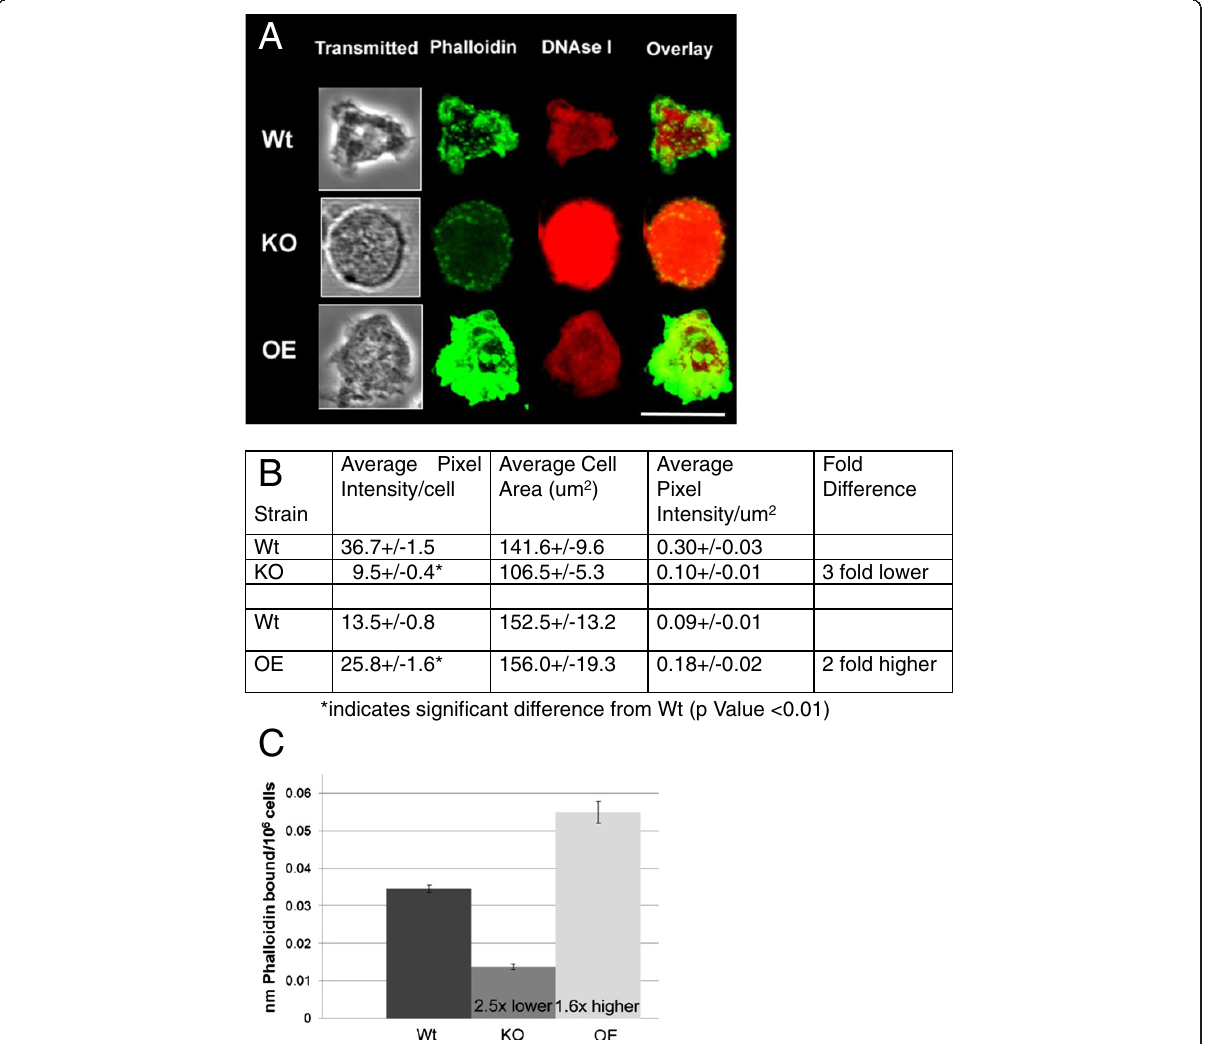
Figure 2 AmpA influences the level of polymerized F actin. A ) Wild type, amp A knockout (KO) and overexpresser (OE) cells were stained with Alexa 488-phalloidin to detect F-actin (green) and TRITC labeled DNAse I to detect G-actin (red). Imaging conditions were optimized for levels of phalloidin staining (see Methods). The fields of cells from which the representative individual cells were excised are in Additional file 5. The images are 3D reconstructions from a confocal z series. Scale bar is 20 um. The fluorescent F-actin images were all equally enhanced to more clearly see the F-actin in the ampA knockout. B ) Fields of Wt, KO and OE cells stained with Alexa 488 phalloidin shown in Additional file 5 were quantified (see Methods). The average pixel intensity per cell, cell surface area and pixel intensity/um 2 are shown. Significance was determined by a two-tailed paired Student ’ s t-test with a p value < 0.05 indicated as significantly different from Wild type. 15 to 20 cells per strain were quantified per experiment. The staining experiment was repeated 6 different times with cells grown on different days. C ) The amount of Alexa 488-phalloidin bound to cells was determined (see Methods). Results are averages of 3 different experiments with data points in triplicate. Error bars are standard error of the